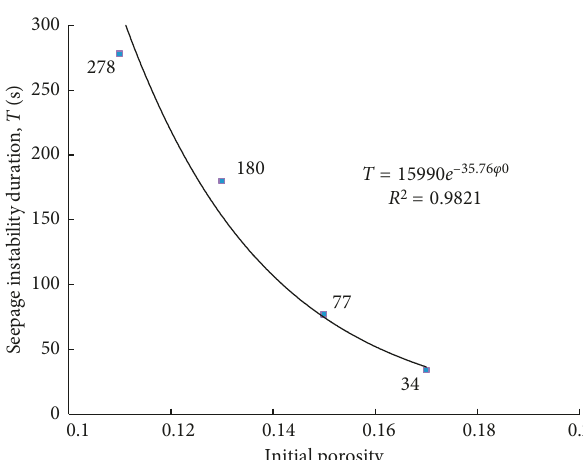
Figure 8: Permeability-time curves of rock specimens cemented by